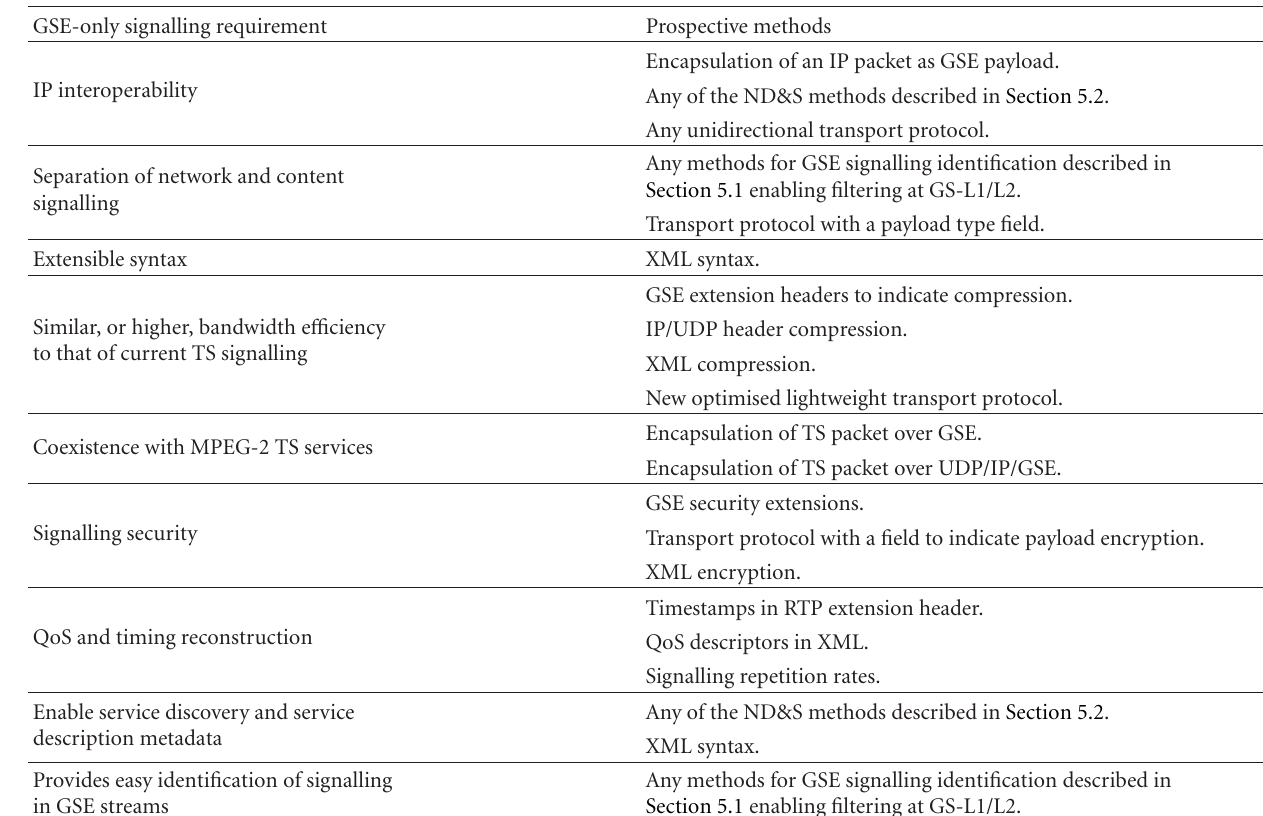
Table 4: Potential methods to fulfill the GSE-only signalling